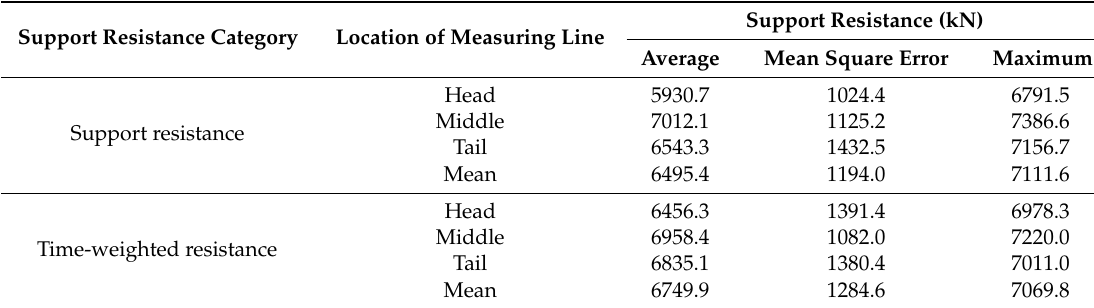
Table 2. Distribution of support resistance under confined